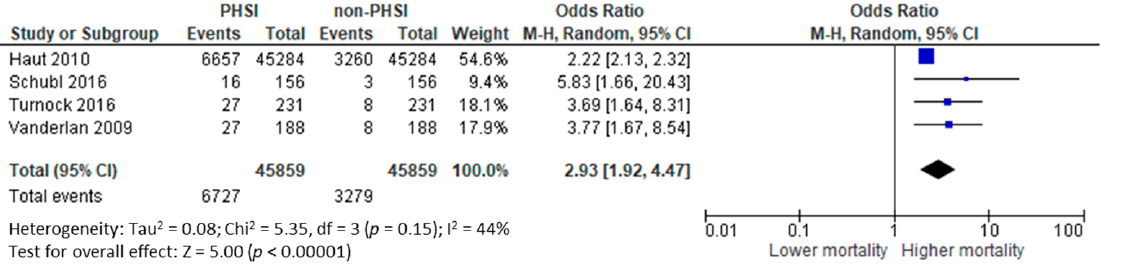
Figure 2. Meta-analysis for overall mortality rates in PHSI vs. non-PHSI patients.